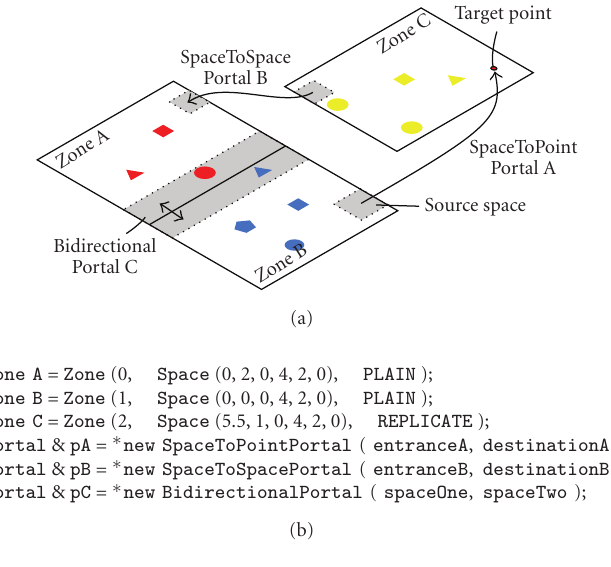
Figure 14: Segmentation specification